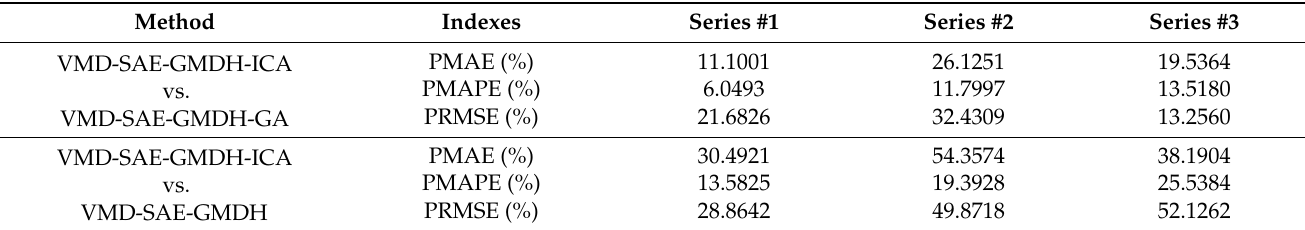
Table 4. The promoting percentages of the VMD-SAE-GMDH-ICA model by the VMD-SAE-GMDH-GA model and the VMD-SAE-GMDH model.